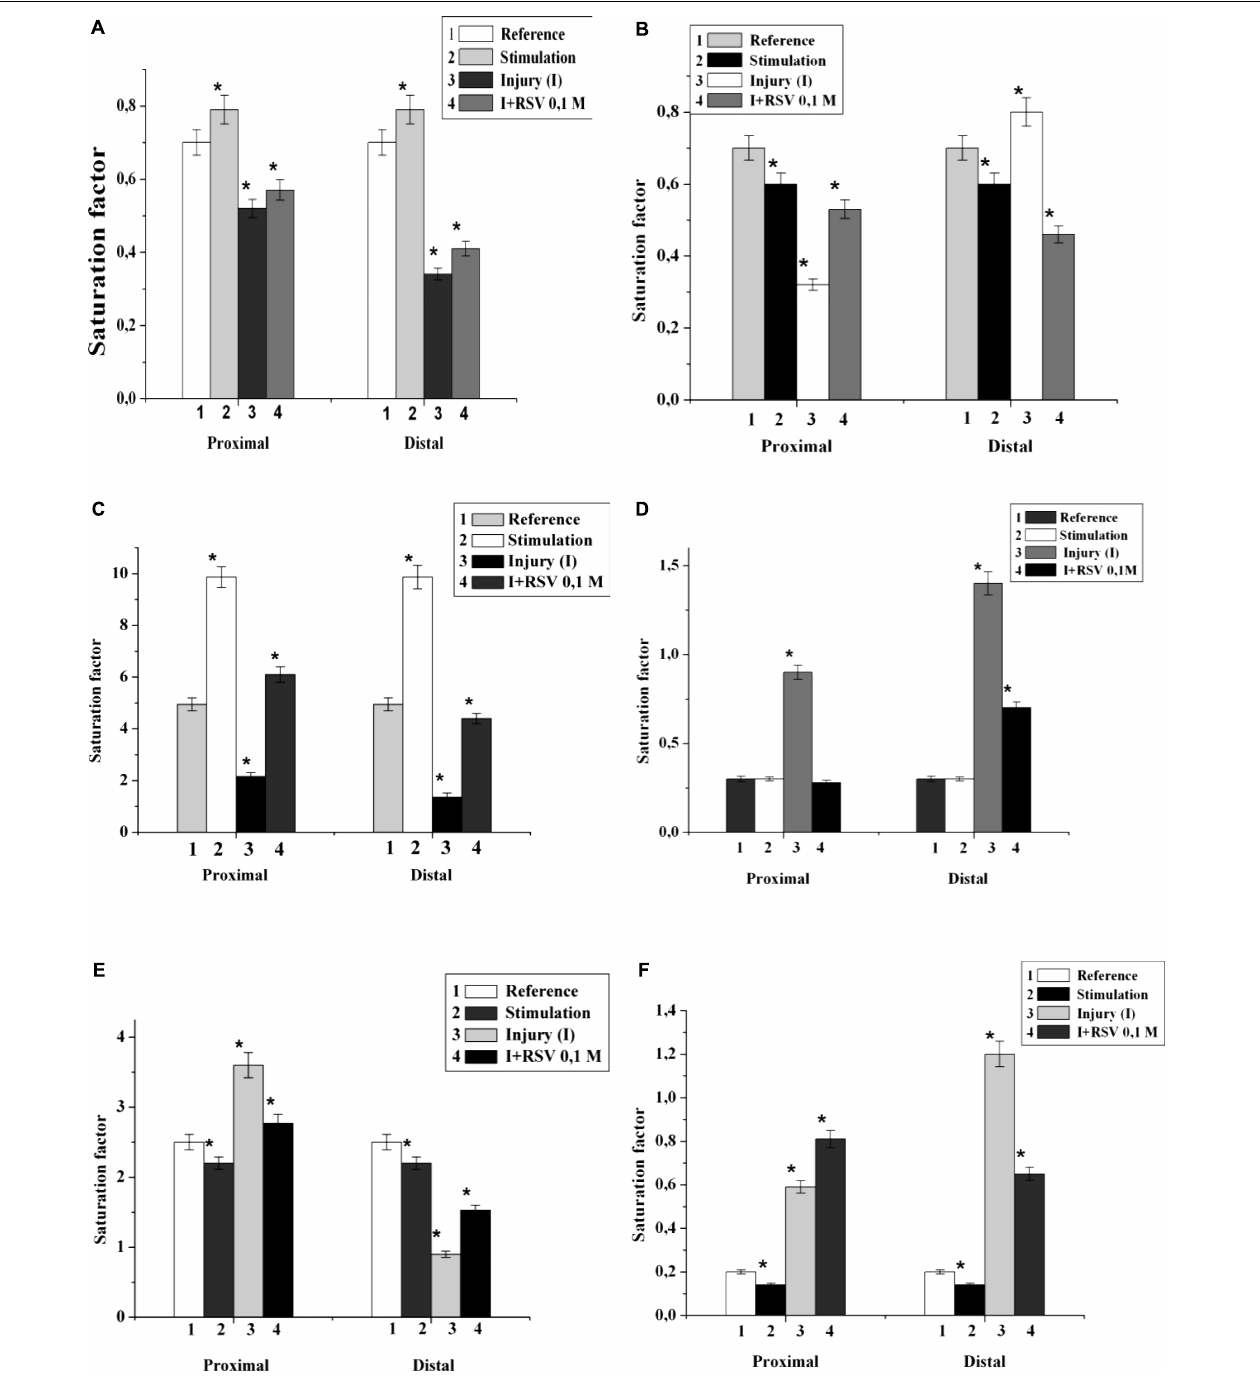
FIGURE 2 | The effect of nerve cutting on the saturation factor of: (A) phosphatidylethanolamine, (B) sphingomyelin, (C) diacylglycerin, (D) phosphatidylserine, (E) phosphatidylcholine, and (F) phosphatidylinositol in the proximal and distal nerve sections. I – injury, RSV – resveratrol, ∗ significance of difference in relation to the control, p <